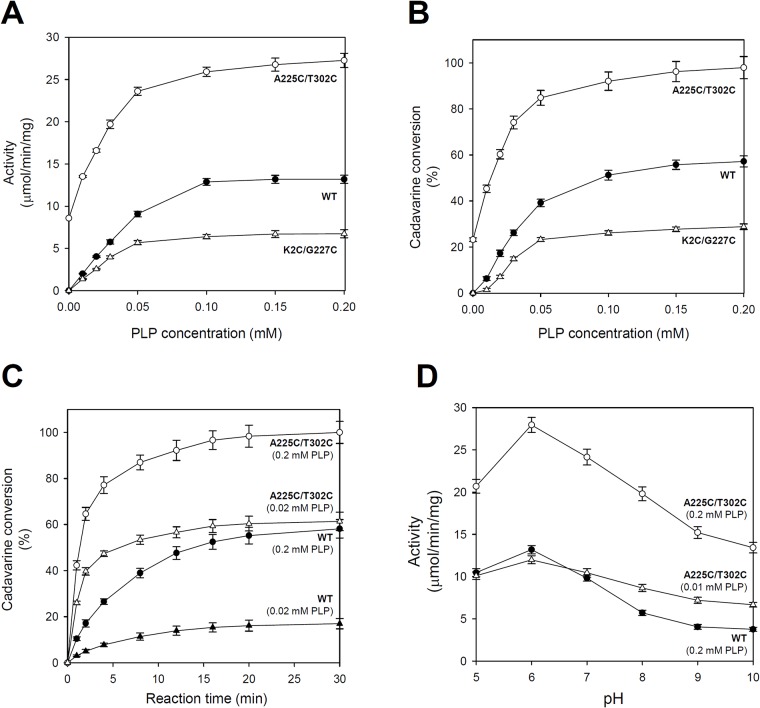
Comparison of LDC activity between SrLDC proteins(A) Comparison of LDC activities of the SrLDC proteins. LDC activities of SrLDCWT, SrLDCK2C/G227C, and SrLDCA225C/T302C are measured at various concentrations of PLP. (B) Comparison of cadaverine conversion of the SrLDC proteins. Cadaverine conversion of SrLDCWT, SrLDCK2C/G227C, and SrLDCA225C/T302C are measured at various concentrations of PLP. (C) Comparison of time-course cadaverine conversion between SrLDCWT and SrLDCA225C/T302C. Time-course cadaverine conversion of SrLDCWT and the SrLDCA225C/T302C mutant are measured under PLP concentrations of 0.02 and 0.2 mM. (D) Comparison of resistance to pH between SrLDCWT and SrLDCA225C/T302C. The LDC activity of SrLDCWT is measured at pH from 5 to 10 under 0.2 mM PLP. The LDC activities of the SrLDCA225C/T302C mutant are also measured at the same pH range under 0.01 and 0.2 mM PLP.